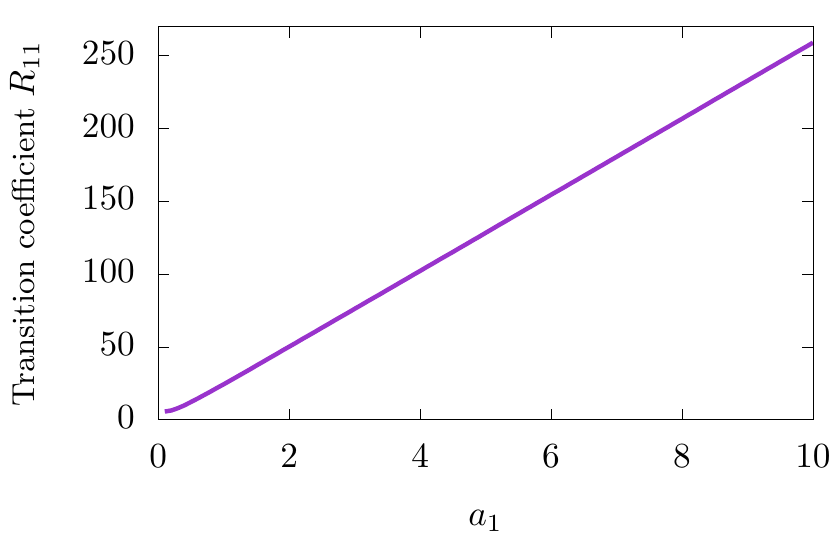
Figure 17 . The response function R 11 (∆ E ) , plotted with respect to varying a 1 for accelerated atoms in thermal background considering the Rindler modes in (1 + 1)